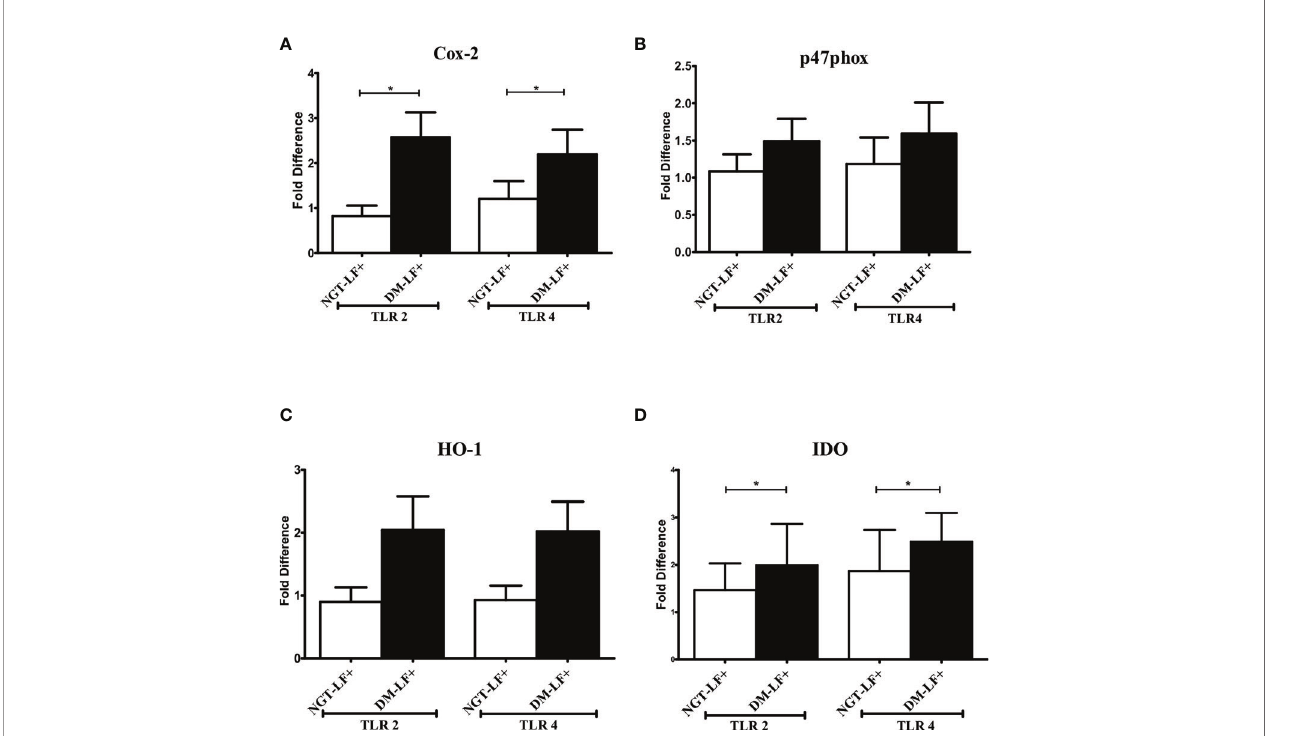
FIGURE 3 | Effect of diabetes on the TLR-induced expression of immunomodulatory effectors in LF+ subjects. Bar graph showing TLR2- and TLR4-induced expression of Cyclooxygenase (Cox)-2 (A) , p47Phox (B) , Heme Oxygenase (HO)-1 (C) , and Indoleamine 2,3-dioxygenase (IDO) (D) in the immune cells in NGT-LF+ and DM-LF+ subjects. Statistical signi fi cance was determined by non-parametric Mann – Whitney U test and p < 0.05 was considered signi fi cant. * p < 0.05. NGT, normal glucose tolerance; DM, diabetes